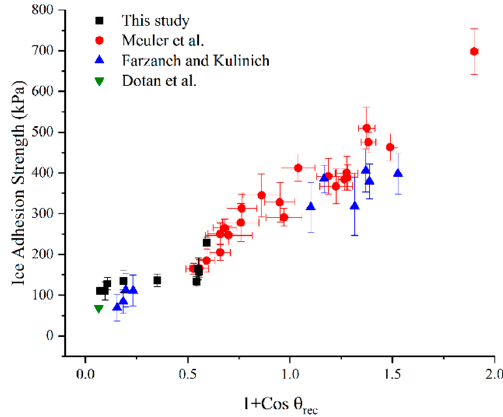
Figure 9. Correlation between ice adhesion strength and the practical work of adhesion (see Equation (1)) compared with the data derived from [4,6,29].